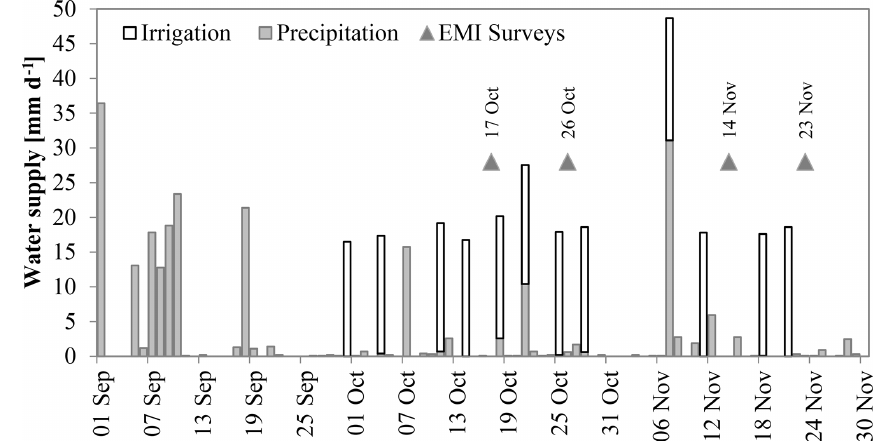
Figure 3. The details of irrigation events and precipitation information during the experiment. The dates of EMI measurements are marked with